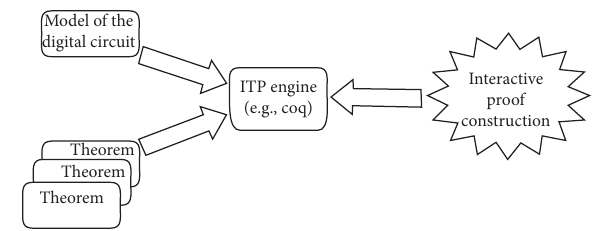
Figure 1: Formal verification of digital